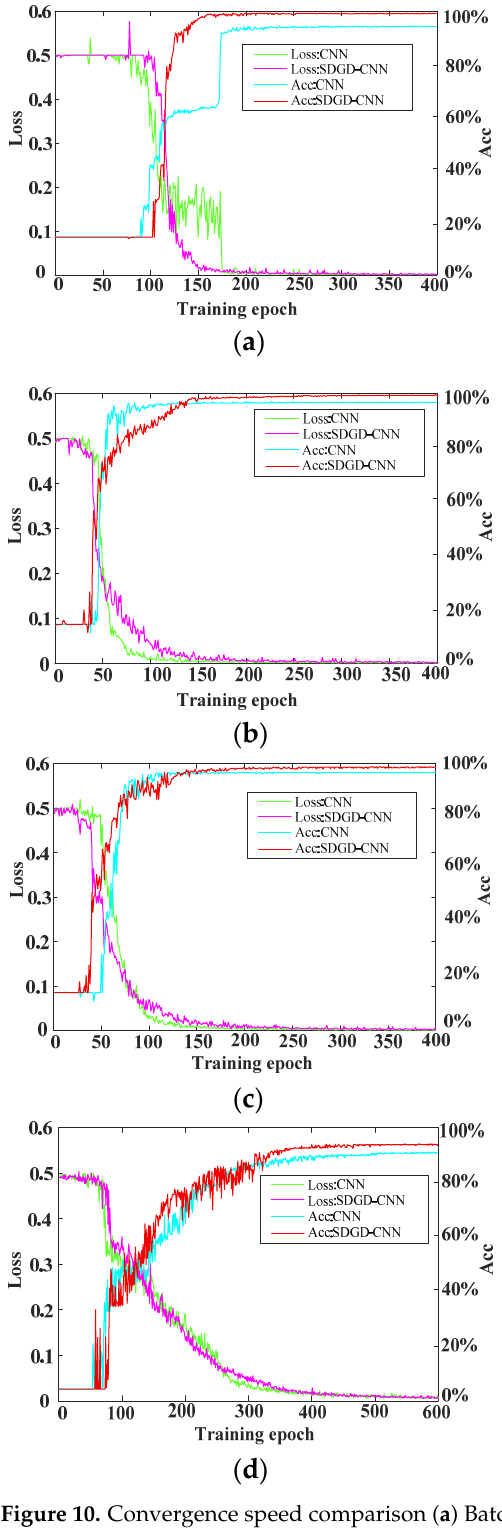
Figure 10. Convergence speed comparison ( a ) BatchSize = 40 ( b ) BatchSize = 50 ( c ) BatchSize = 100 ( d ) BatchSize = 200. The diagnostic accuracy comparisons are shown in Table